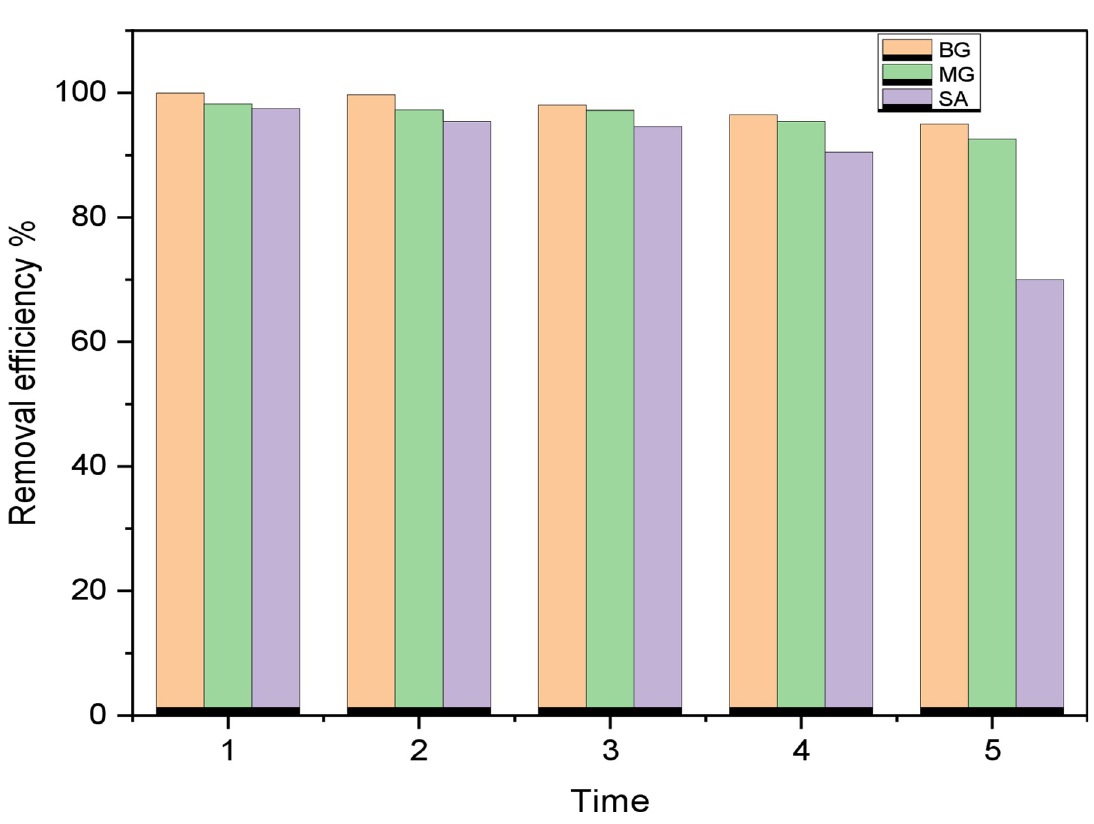
Fig 10. Reusability of adsorbent for dyes removal